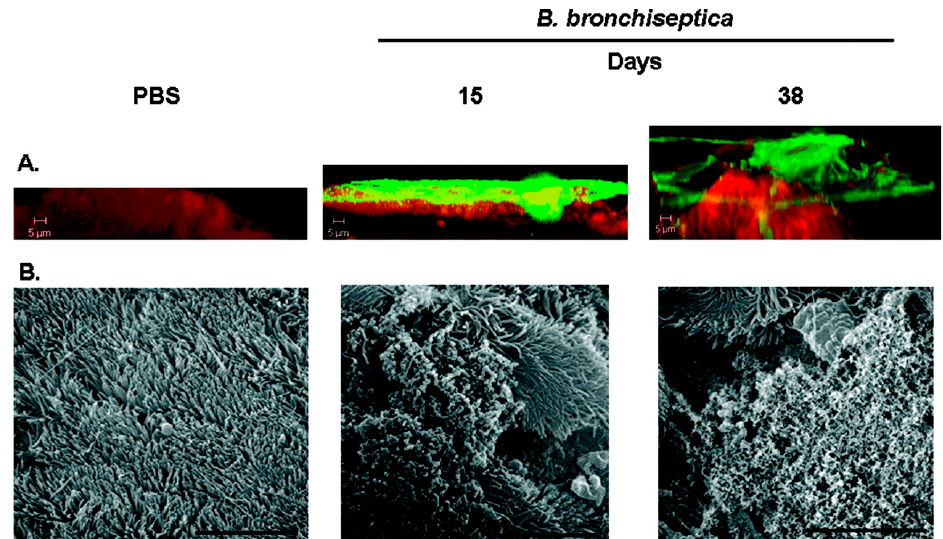
Figure 7. ( A ) Confocal laser scanning microscopy (CLSM) of biofilms formed within the murine nasal cavity by B. bronchiseptica . C57BL/6 mice were inoculated with either PBS or B. bronchiseptica RB50. Nasal septa were harvested at 15 or 38 days postinoculation, immediately fixed, and probed with rat anti-Bordetella serum followed by a secondary anti-rat antibody conjugated to Alexa Fluor 488 (which stains bacteria green). To determine the localization of the host epithelium, specimens were stained for F-actin using phalloidin conjugated to Alexa Fluor 633 (which stains the epithelium red) and visualized with. Each micrograph represents a Z reconstruction. For each specimen, images were obtained from at least five areas of the nasal septum and from at least three independent ani- mals. ( B ) Scanning electron microscopy of B. bronchiseptica biofilm formation on nasal septa. Spec- imens were collected from animals either 15 days or 38 days post-inoculation, directly fixed, and processed for scanning electron microscopy. Scale bars = 10 μ m. Reprinted from [86] .